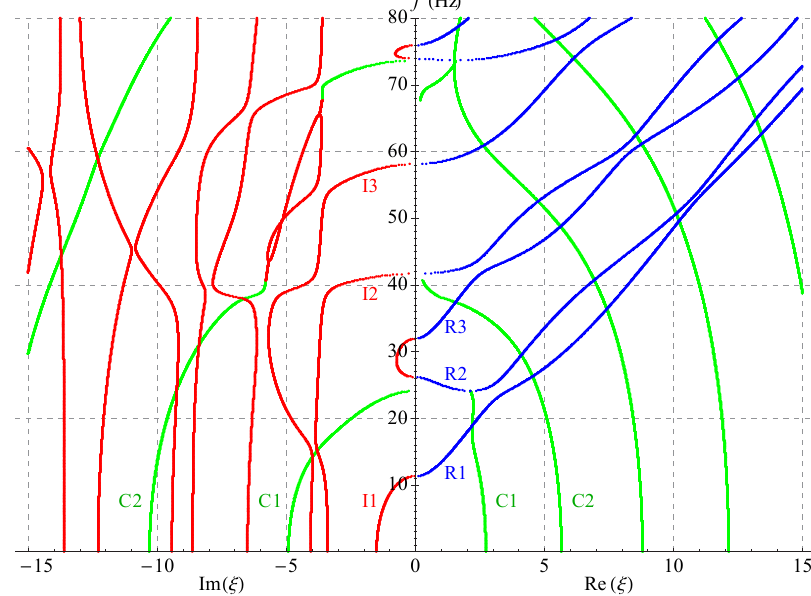
Figure 5. Two-dimensional full frequency spectra ( n =